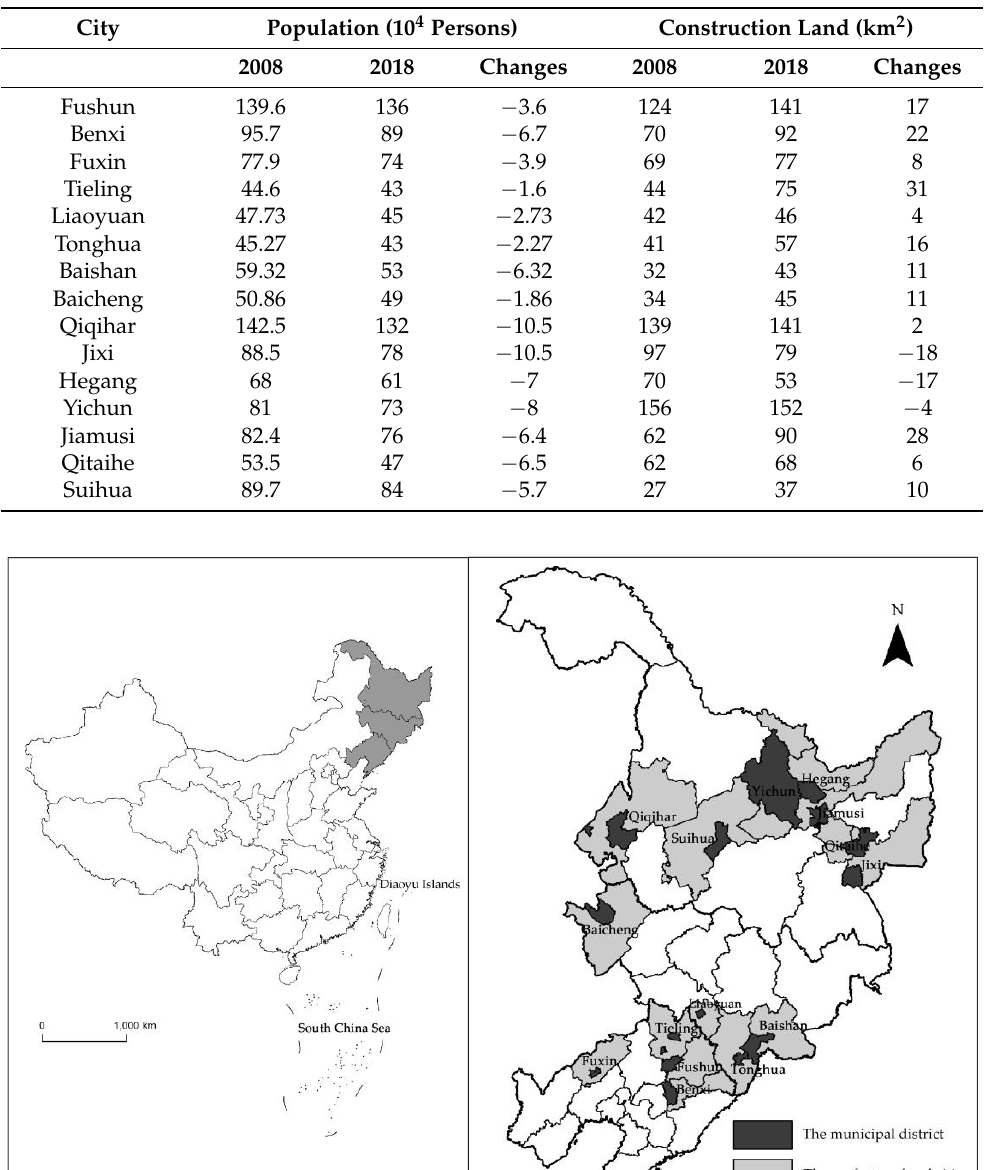
Table 1. Changes in population and construction land in shrinking cities.